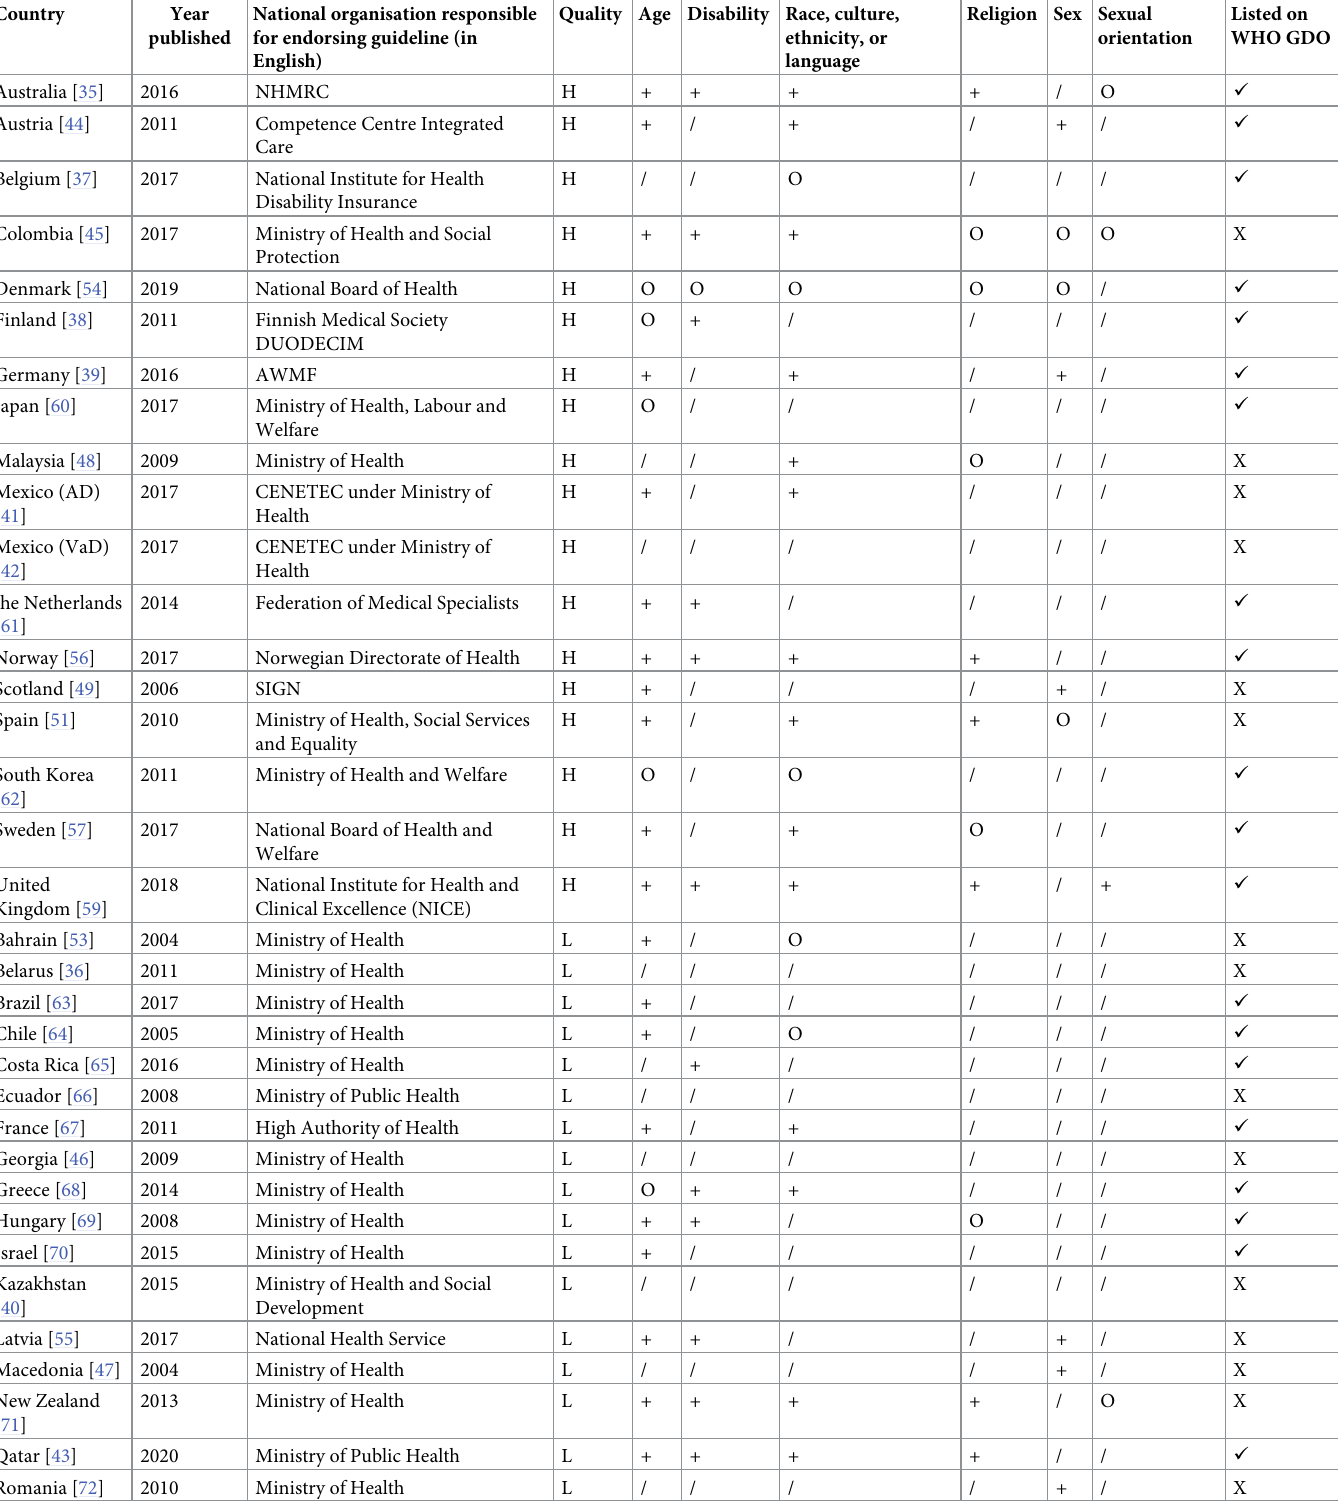
Table 1. Guidelines and their country of origin, quality, and inclusion of recommendations related to protected characteristics.